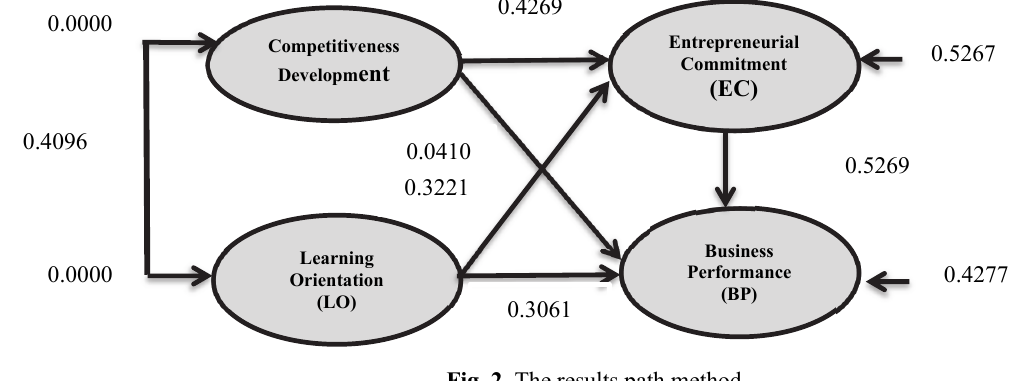
Fig. 2. The results path